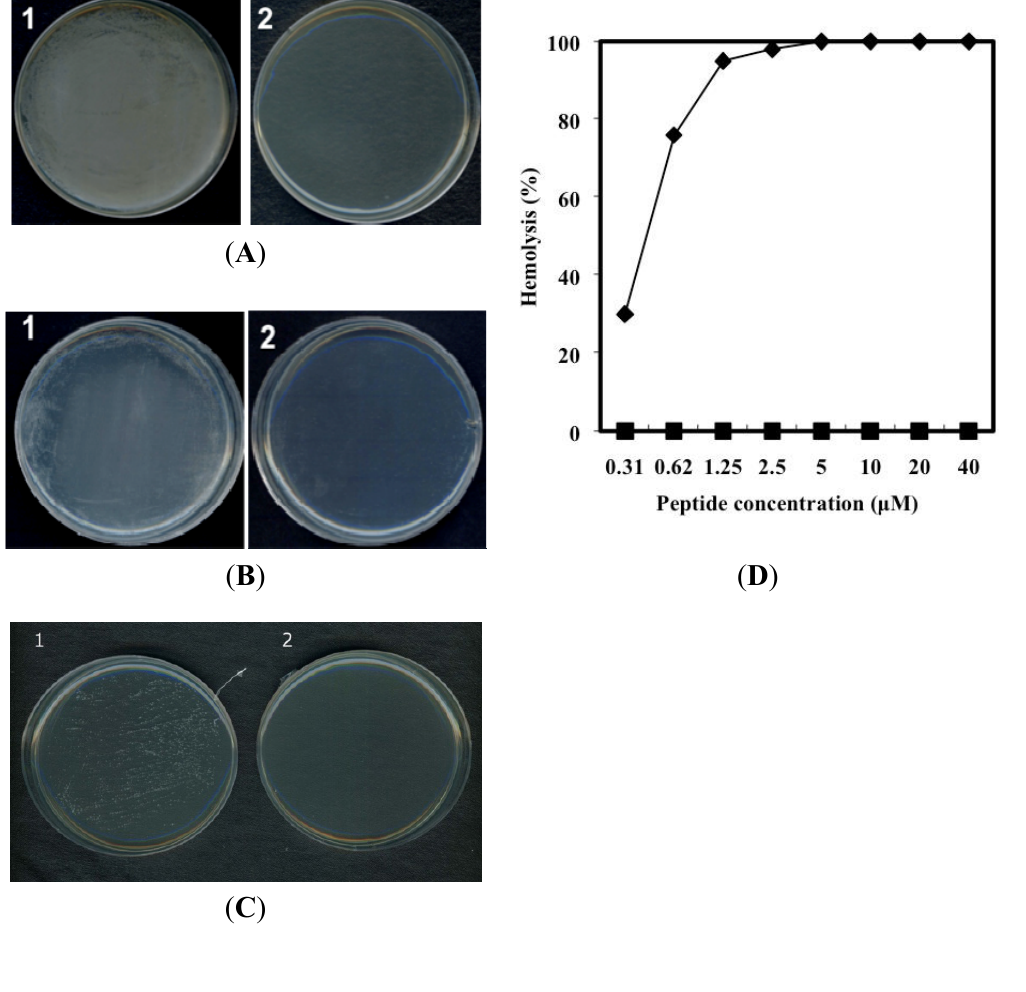
Figure 3. Assays of PG-2 activity against bacterial and fungal strains. ( A ) Antibacterial activity of PG-2 against the plant pathogen Clavibacter michiganensis subsp